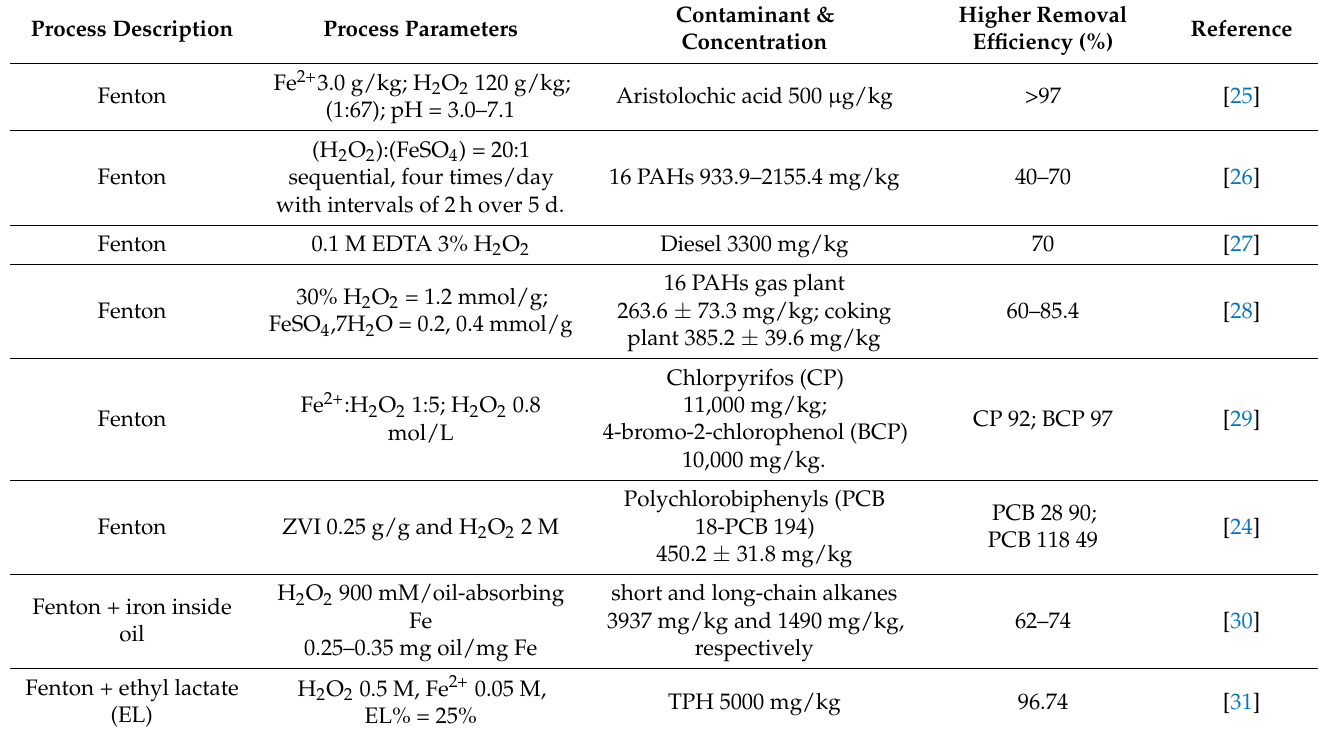
Table 1. Selected published articles on the Fenton-based process for soil decontamination.